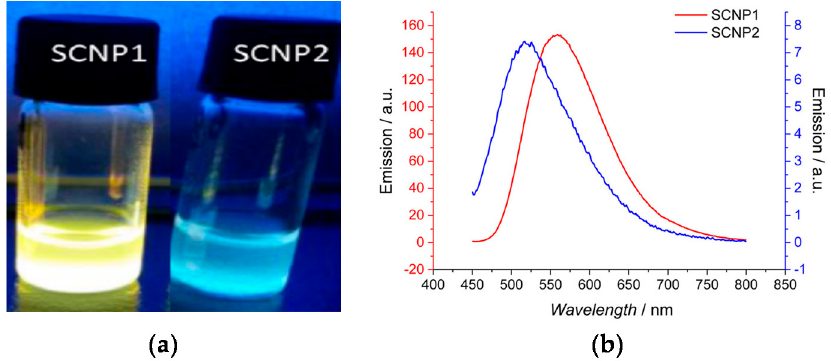
Figure 9. Fluorescent SCNPs produced via nitrile imine-carboxylic acid ligation (SCNP1) as well as nitrile imine-mediated tetrazole-ene cycloaddition (SCNP2) ( a ), and photophysical characterization of SCNP1 and SCNP2 ( b ) (reprinted with permission from [57], Copyright American Chemical Society, 2017).